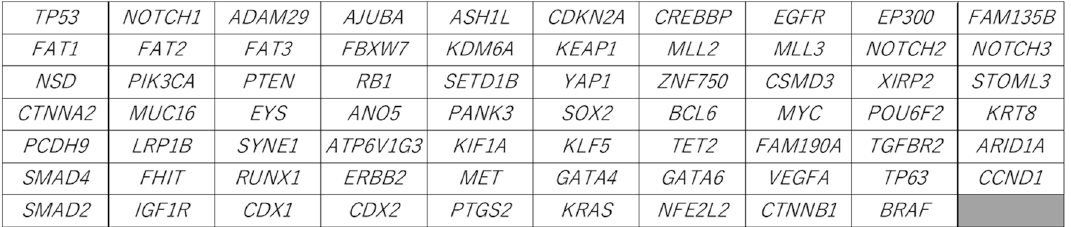
Figure 2. List of 69 significant mutated genes included in the panel. Each box shows each gene included in the